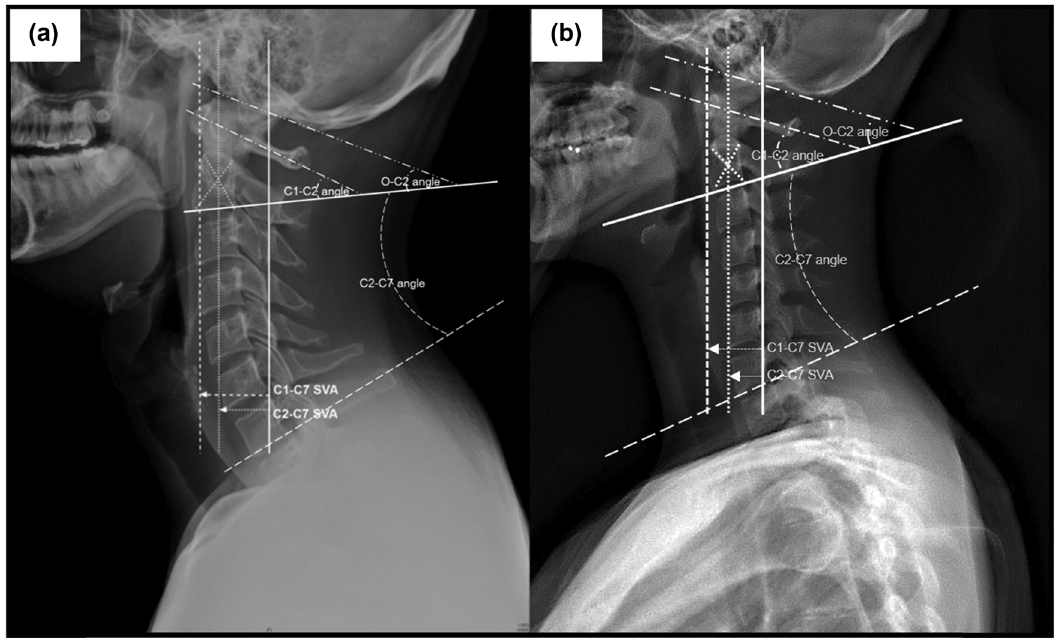
Figure 1: Parameters of sagittal cervical alignment on plain radiographs. ( a ) The lordotic group: O – C2 angle, angle between the McGregor line and the lower endplate of C2; C1 – C2 angle, angle between a line connecting the anterior tubercle to the posterior margin of the C1 spinous process and the lower endplate of C2; C2 – C7 angle, angle between the lower endplate of C2 and C7 determined with Cobb ’ s method; C1 – C7 SVA, distance between the plumb line from the anterior arch of C1 and the posterior - superior corner of C7; C2 – C7 SVA, distance between the plumb line from the centroid of C2 and the posterior - superior corner of C7. ( b ) The non - lordotic